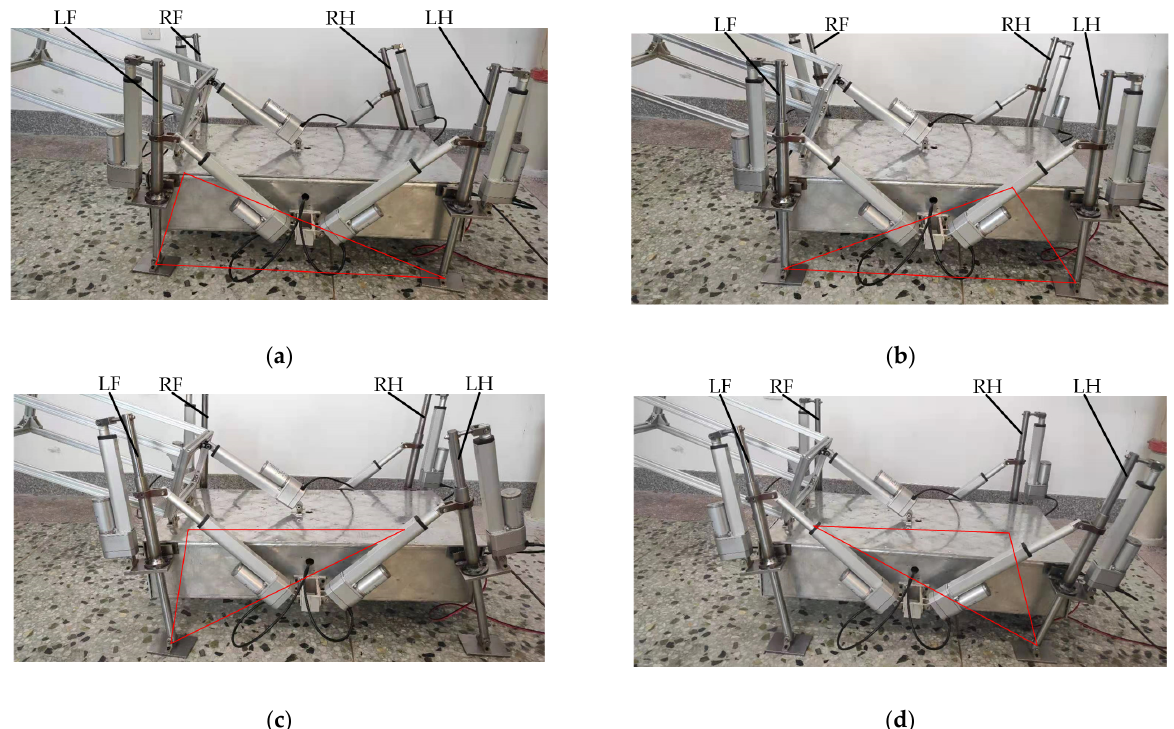
Figure 15. The motion state of the experimental prototype in a cycle in the coordinated gait: ( a ) the RH is about to lift, ( b ) the RF is about to lift, ( c ) the LH is about to lift, and ( d ) the LF is about to lift.